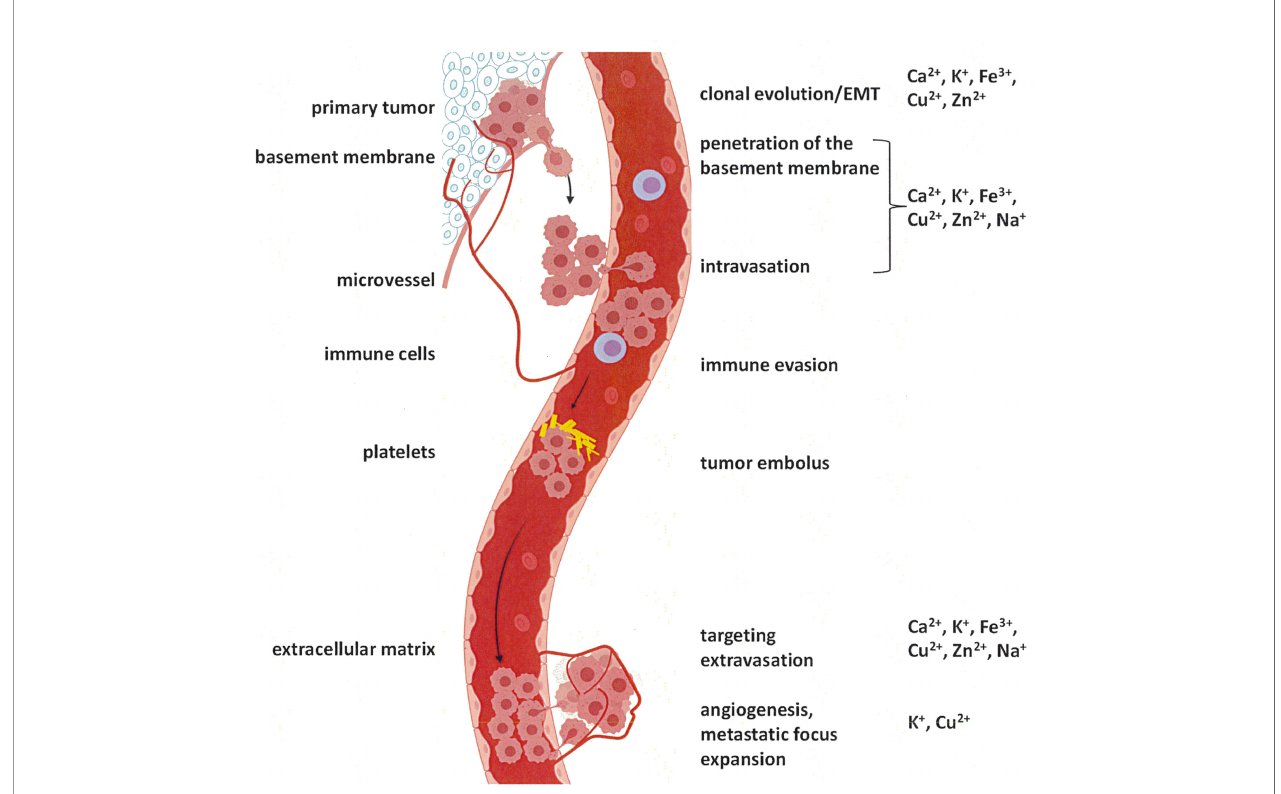
FIGURE 1 | The metastatic cascade. Tumor cells initially break through the basement membrane at the site of origin. From there, they enter the circulation (blood or lymph stream), survive, and enter the tissue at the target site. Preparation of a pre-metastatic niche (10) may be required, but is not depicted (adapted from (11) using